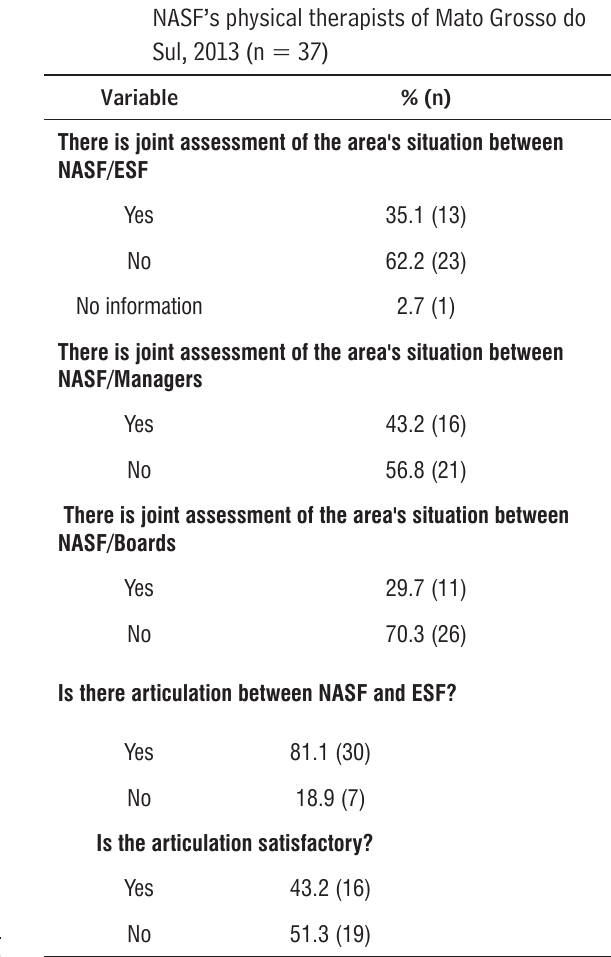
Table 2 - Variables related to the work process of NASF’s physical therapists of Mato Grosso do Sul, 2013 (n =